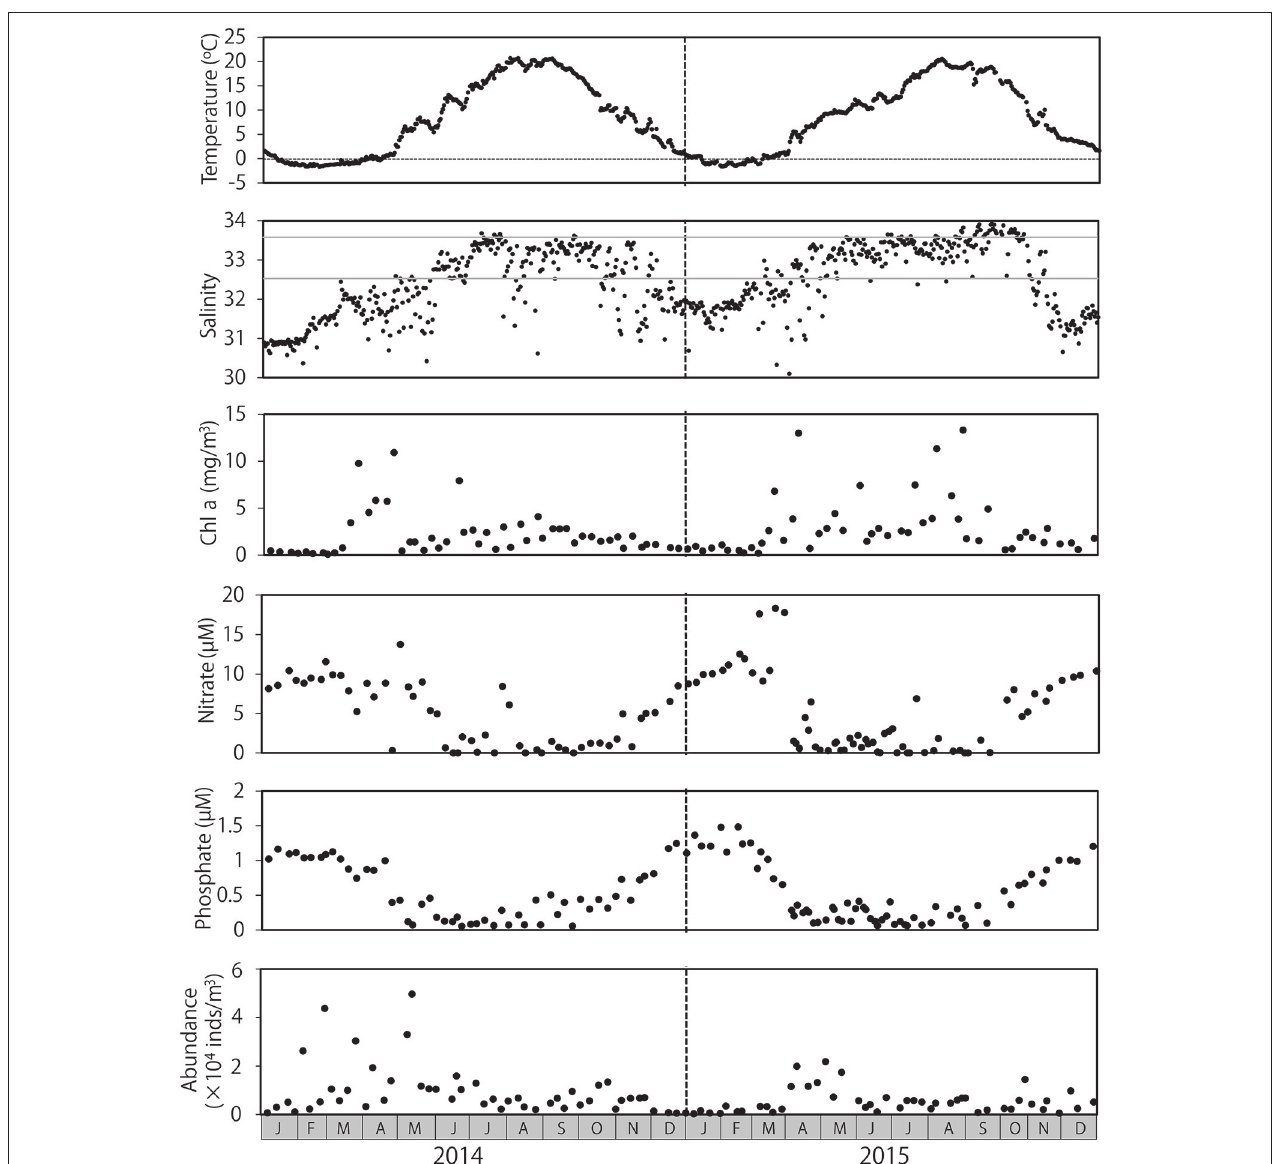
FIGURE 1 | Seasonal changes in environmental conditions and overall zooplankton abundance at Okhotsk Tower, in the coastal waters of northeastern Hokkaido. Water temperature and salinity are provided as means throughout the water column. The concentrations of chlorophyll a , nitrate, and phosphate were measured at the surface. Gray lines in salinity (32.5 and 33.6) indicate the influence of the Okhotsk Sea surface water and Soya Warm Current,